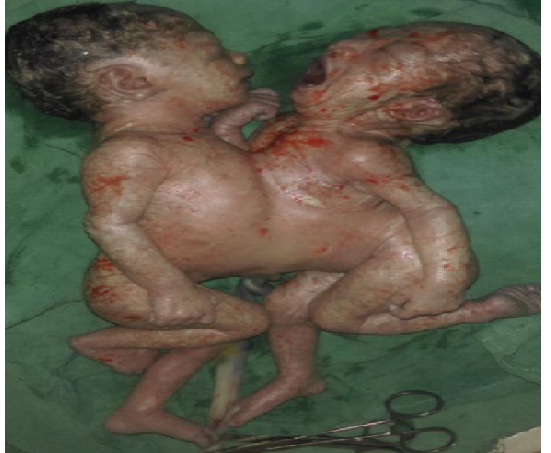
Figure 3: CT scan of the conjoined twins post delivery showing level of